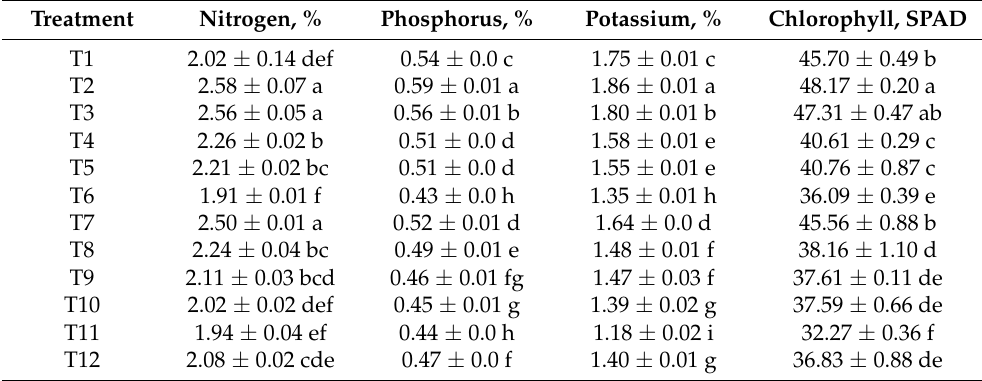
Table 4. Effect of potassium treatments on nitrogen, phosphorus, potassium, and chlorophyll contents of strawberry plant foliage in the combined seasons of 2019/20 and